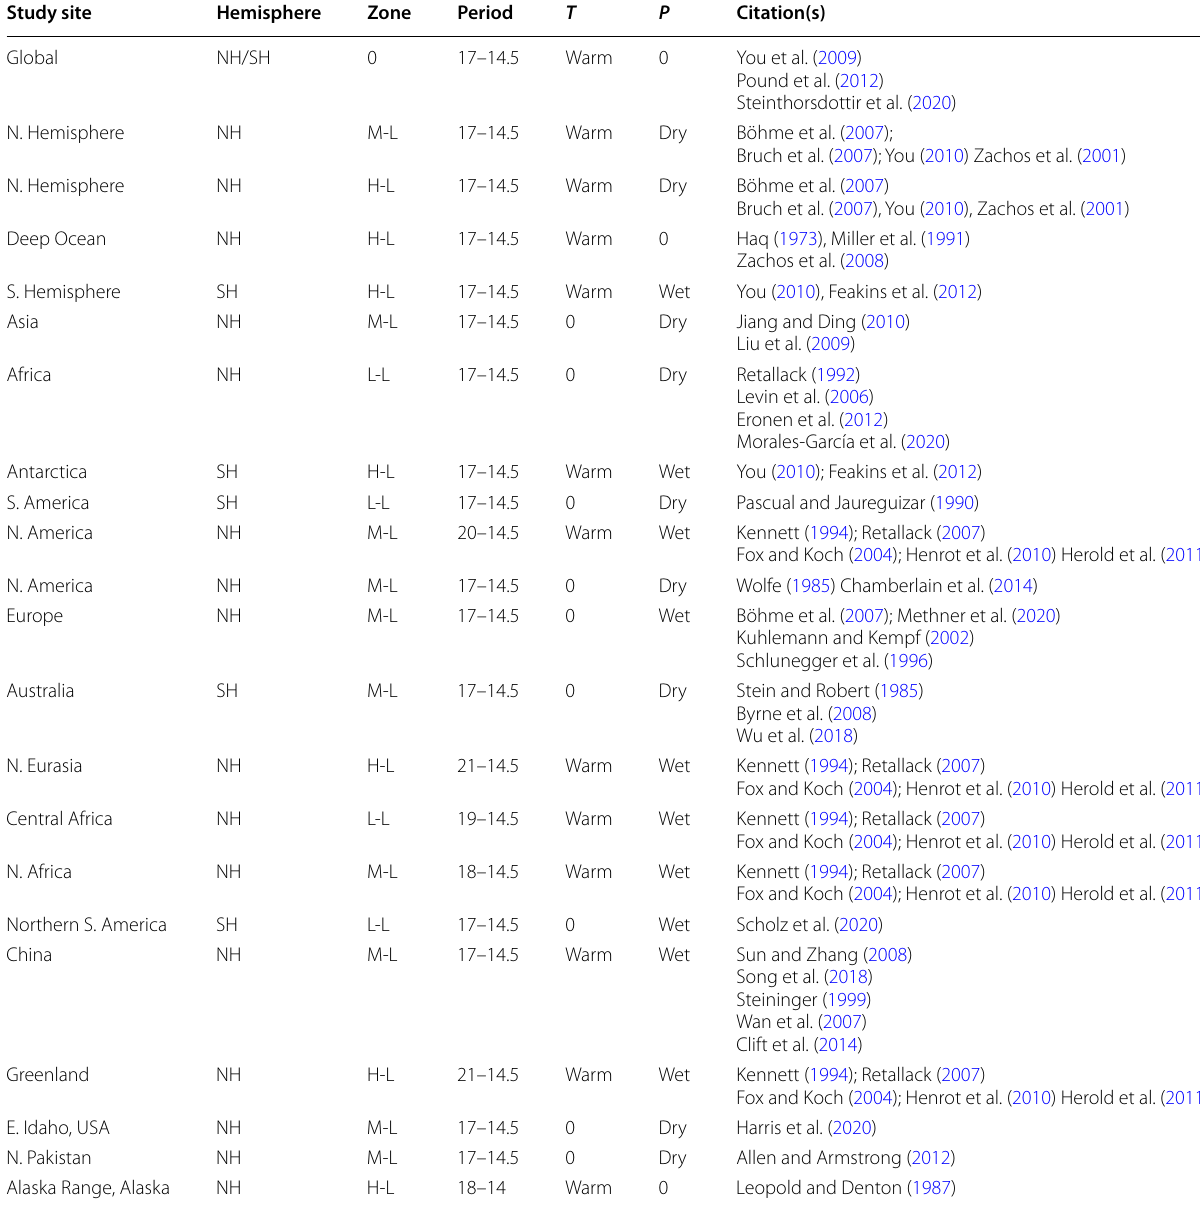
Table 1 Temperature and precipitation conditions during the